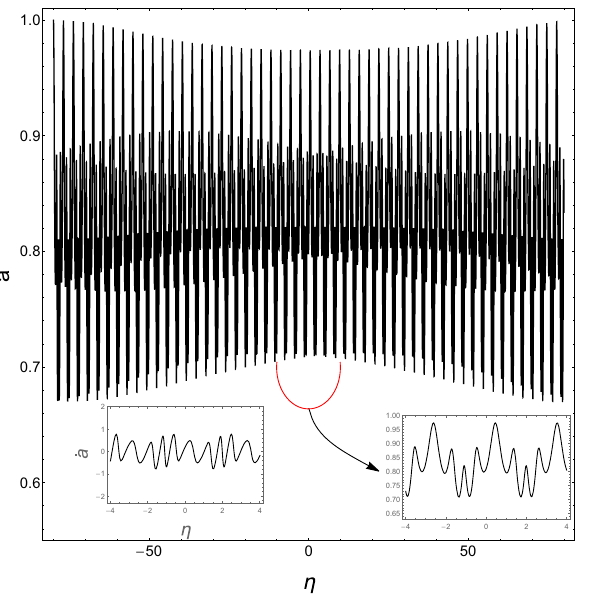
Z 0 = 0 . 33 and Q 0 = − 0 . 3166. The right insets show the behavior of a and (cid:3) within a shorter time interval and the left ones are plotted for time derivatives of these quantities